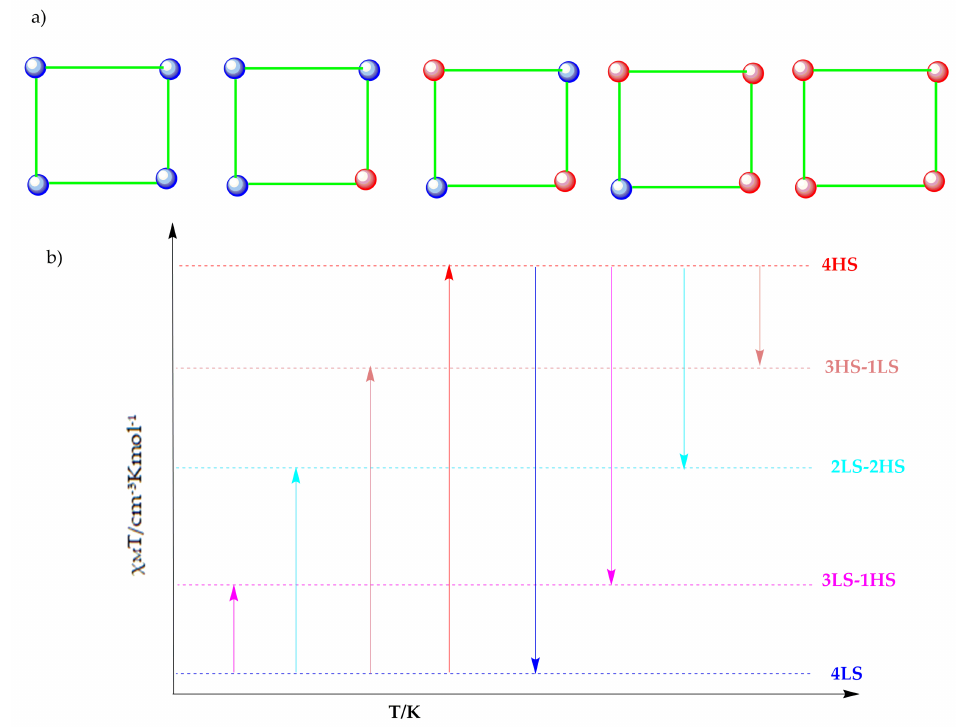
Figure 10. ( a ) Fe 4 L 4 grid SCO complexes; blue = LS iron(II), red = HS iron(II) and green = N 6 /N 4 O 2 Schiff base ligands. ( b ) Types of spin state switching in grid